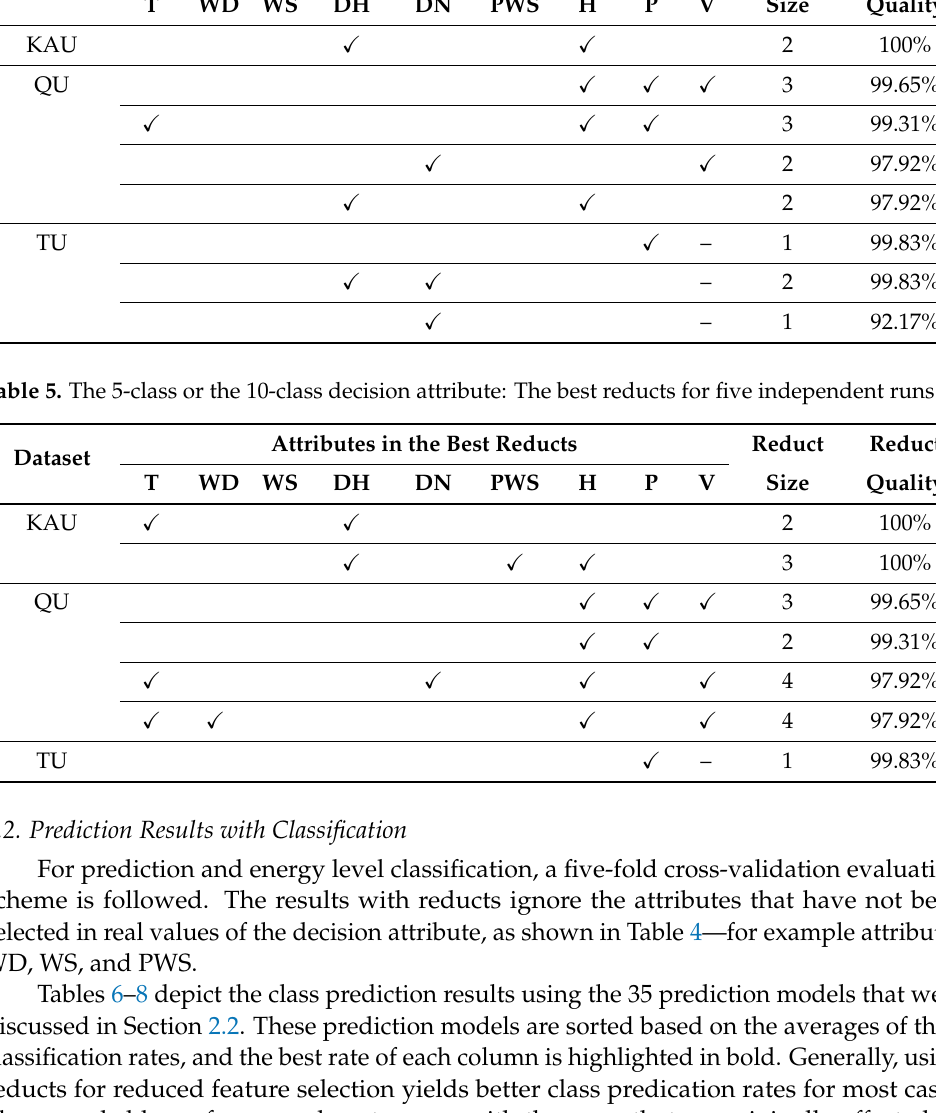
Figure 9. The 10-class decision attribute: Distributions of γ -values of reducts with dual and single attributes. Table 4. The real values of the decision attribute: The best reducts for five independent runs. Attributes in the Best Reducts Dataset